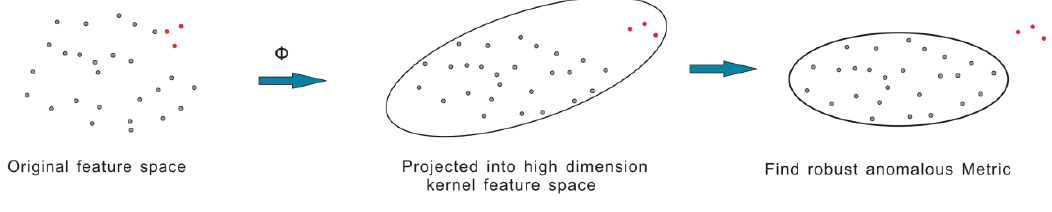
Fig. 1 The schematic flow sheet of our method. The black dots represent the background pixels, and the red ones corresponding to the anomaly